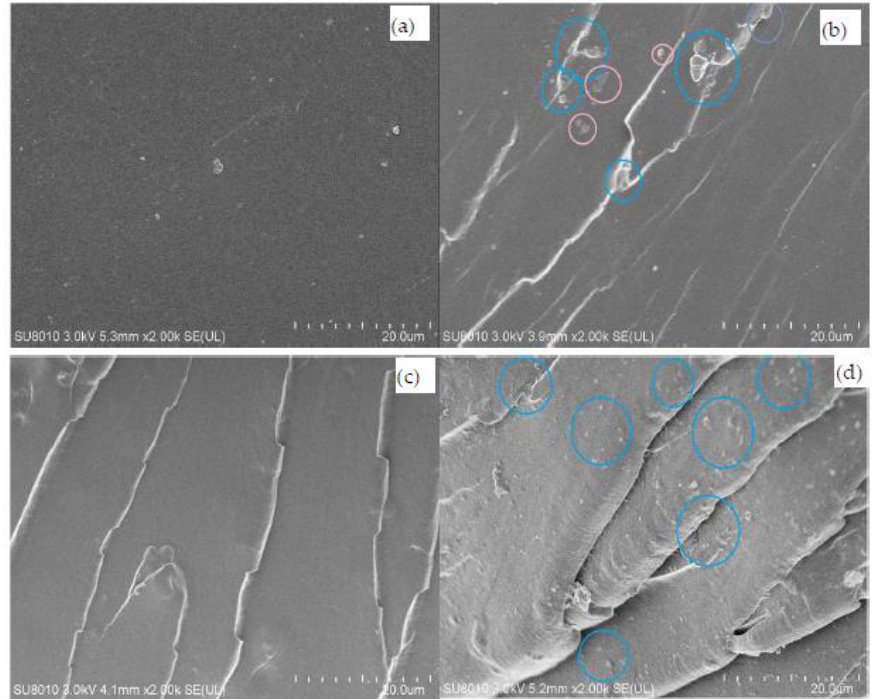
Figure 9. FESEM images of: the unmodified epoxy thermosets ( a ); the epoxy thermosets modified with 3% CSPs ( b ); the epoxy thermosets with 10 wt % ATHBP ( c ); and the epoxy/ATHBP thermosets modified with 3% CSPs ( d ).